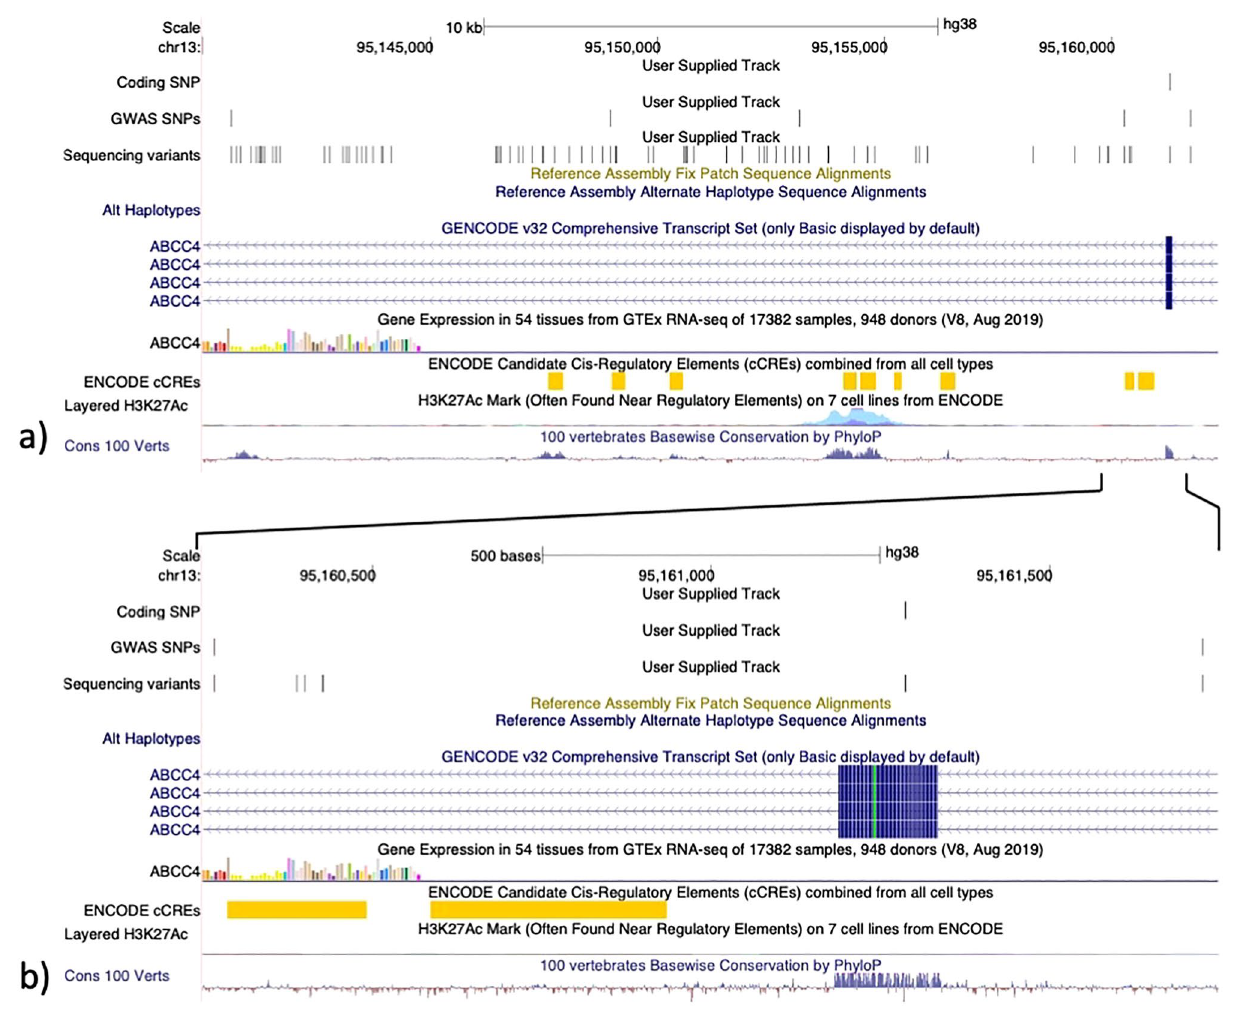
Figure 4. Detailed view of the associated locus on chromosome 22 lifted over to the human genome GRCh38. ( a ) Liftover of identified genetic variants located with the complete LD locus from CanFam3.1 to hg38. A separate track shows the location of the five associated GWAS SNPs and the identified coding variant within ABCC4. ( b ) Zoom in on the coding variant and the two nearest associated GWAS SNPs lifted over to human hg38. Tracks below the coding track include the ENCODE cis-regulatory elements track, the gene expression track, the Multix Alignments of 100 Vertebrates conservation track and the H3K27Ac regulatory elements track 9